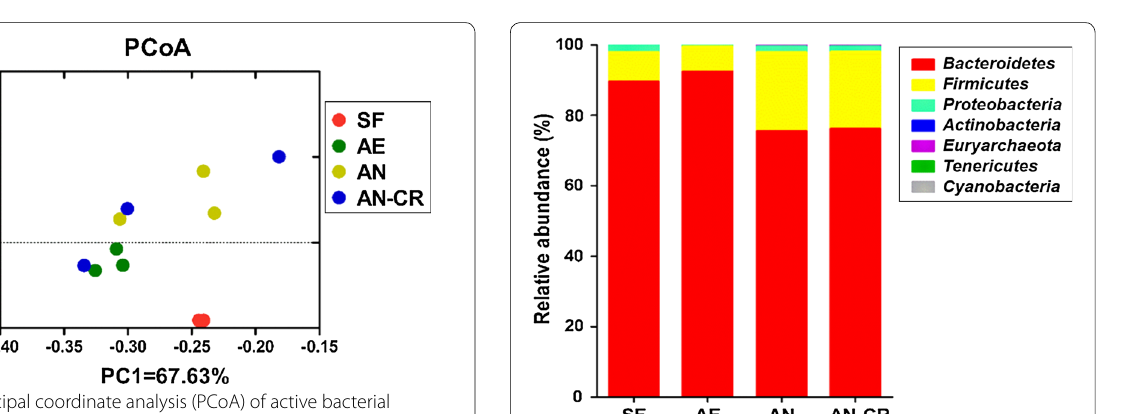
Data are expressed as mean and standard error of means (SEM), n another SF sows’ fecal group, AE aerobic group, AN anaerobic group, AN-CR anaerobic-cryopreserved group